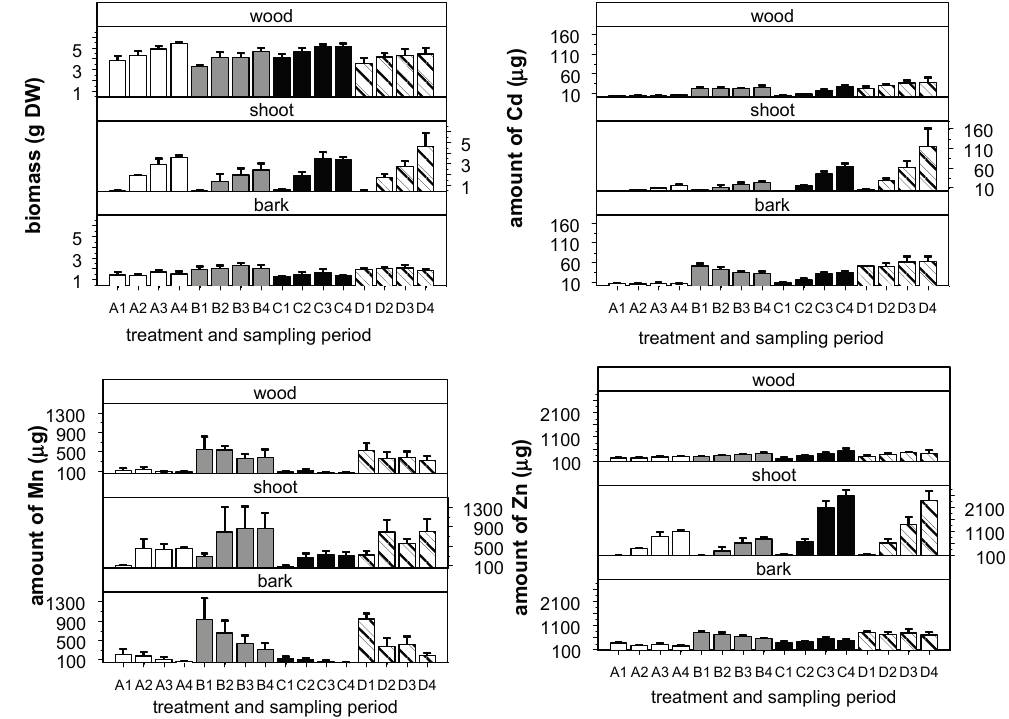
Figure 6. Biomass and amount of Cd, Mn and Zn in wood, shoot and bark per cutting of two origins of willow cuttings (A and C, cuttings from an uncontaminated location; B and D, cuttings from a contaminated location) sampled after (1) 10, (2) 15, (3) 20 and (4) 25 weeks growing in two soil types. Values are the averages of four replicates per treatment per sampling event (error bars indicate the standard deviation for four replicates; DW, dry